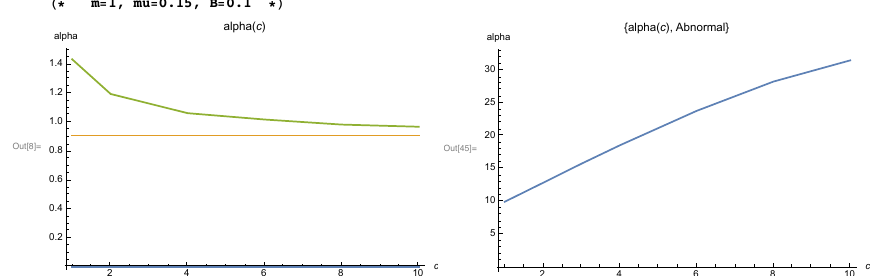
Figure 4. The coupling constant α vs. speed of light c for the parameters m = 1, µ = 0 . 15, B = 0 . 1. Left panel: Decreasing line is found from the relativistic equation (10) for the "normal" solution; horizontal line is the limiting value of the decreasing line, the coupling constant in the Yukawa potential in the Schrödinger equation. Right panel: For the "abnormal" solution At the left panel of Fig. 4 we see that in the non-relativistic limit ( c → ∞ ) α decreases and tends to a limiting finite value α ≈ 0 . 9. This value is just the coupling constant in the Yukawa potential providing the binding energy B = 0 . 1 in the Schrödinger equation. There- fore we associate this solution with the "normal" one, having the non-relativistic limit.